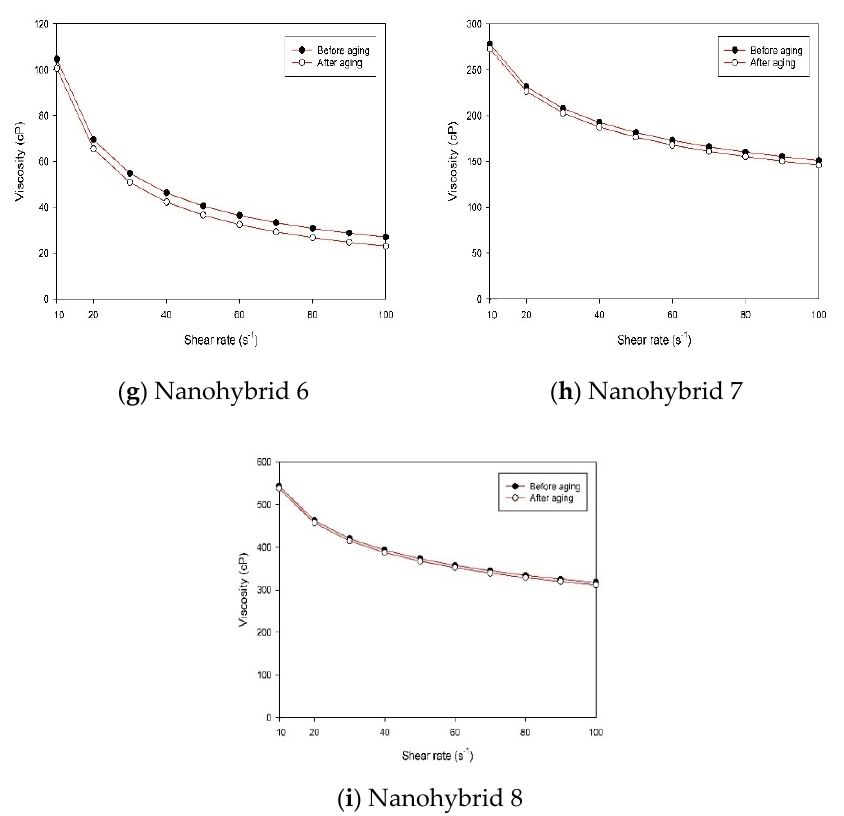
Figure 5. Apparent viscosity vs. shear rate of HPAM polymer solution and nanohybrid systems 1 to 8. T = 85 o C.